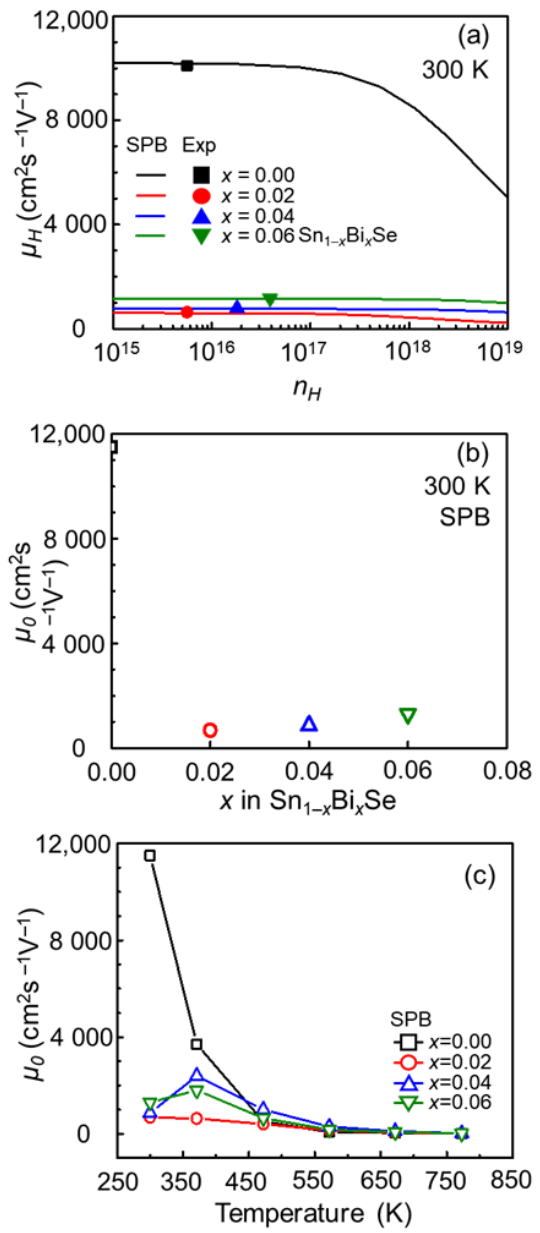
Figure 2. ( a ) Calculated (lines) and experimental (symbols) n H -dependent Hall mobility ( µ H ) for Sn 1 − x Bi x Se ( x = 0.00, 0.02, 0.04, and 0.06) at 300 K [18], ( b ) calculated non-degenerate mobility ( µ 0 ) varying with x in Sn 1 − x Bi x Se ( x = 0.00, 0.02, 0.04, and 0.06) at 300 K, and ( c ) calculated µ 0 for Sn 1 − x Bi x Se ( x = 0.00, 0.02, 0.04, and 0.06) varying with temperature (300–773 K).